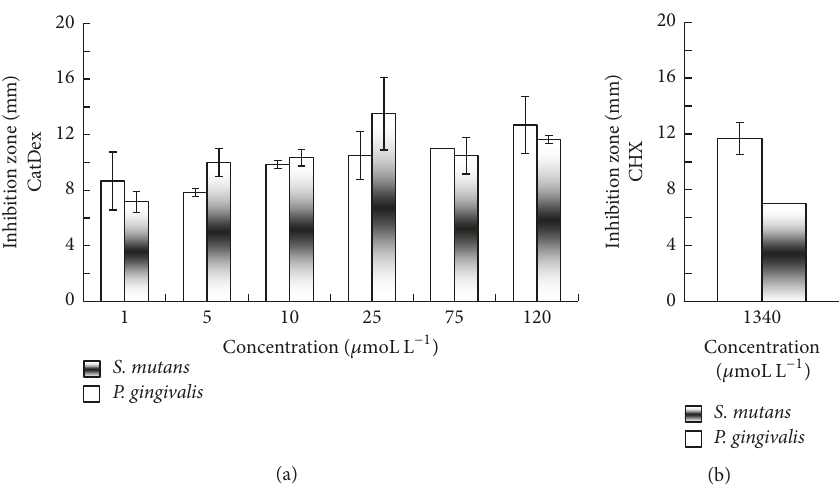
Figure2:DeterminationofthebacterialsusceptibilitytoCatDex(a)andCHX(b)ofstrains S.mutansUA130 and P.gingivalisW83 .Significant differences between CatDex and CHX were observed at all concentrations for both bacteria ( 𝑝 < 0.05 ) except at 1, 25, and 120 𝜇 moLL −1